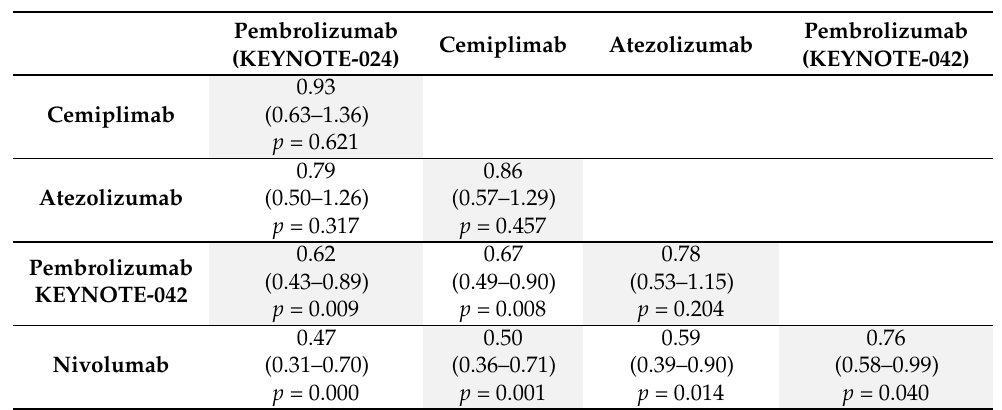
Table 2. Network meta-analysis: PFS (HR, 95% CI and p -values are shown).